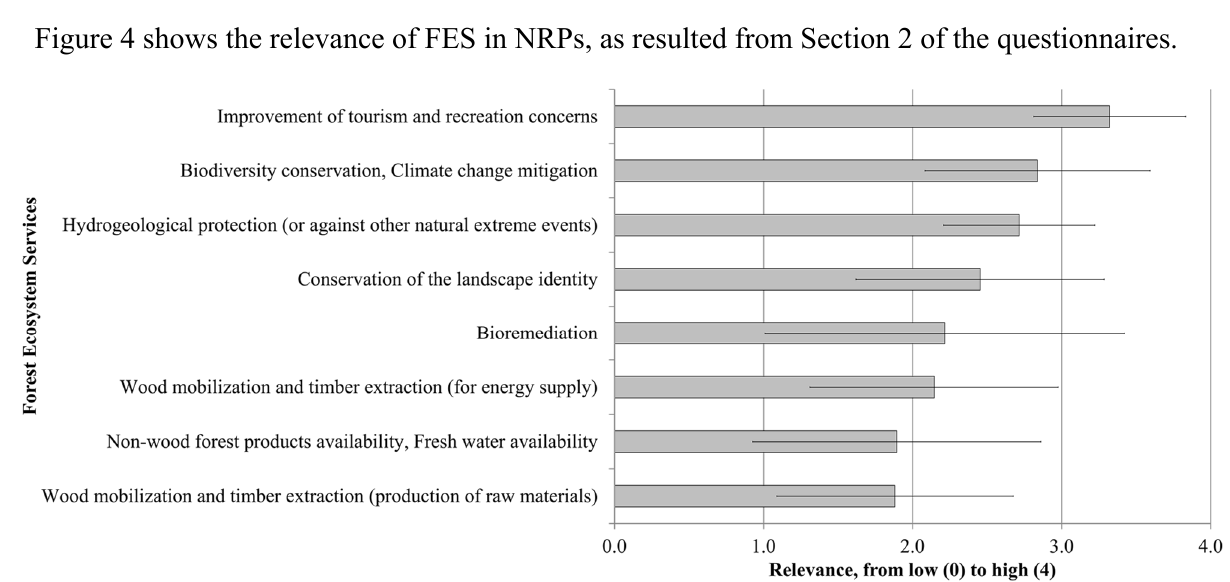
Figure 4. Bar chart reporting the Forest Ecosystem Services (FES) relevance (grouped by Division) in surveyed NRPs. Relevance values vary from very low (0) to very high (4). Bars refer to Standard Deviation (SD)